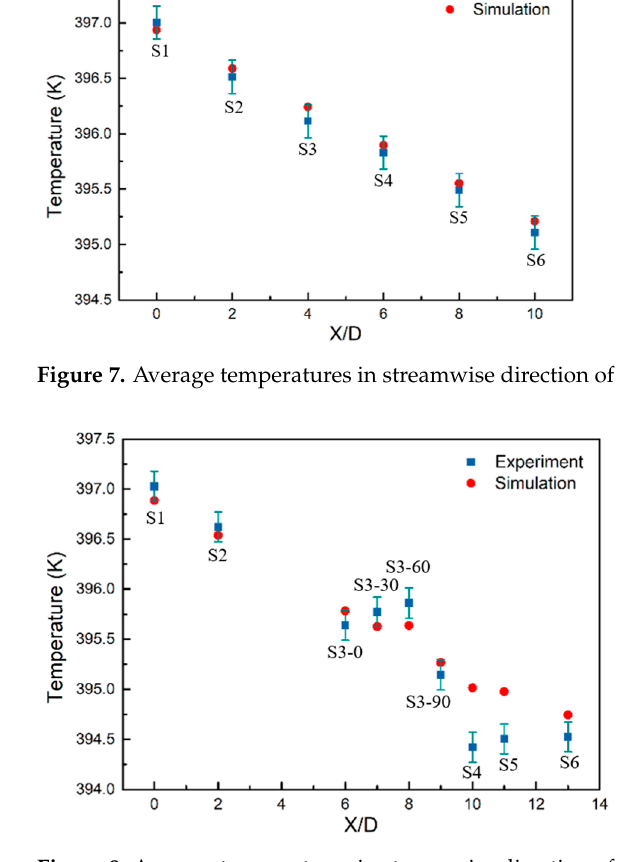
Figure 8. Average temperatures in streamwise direction of curved pipe.